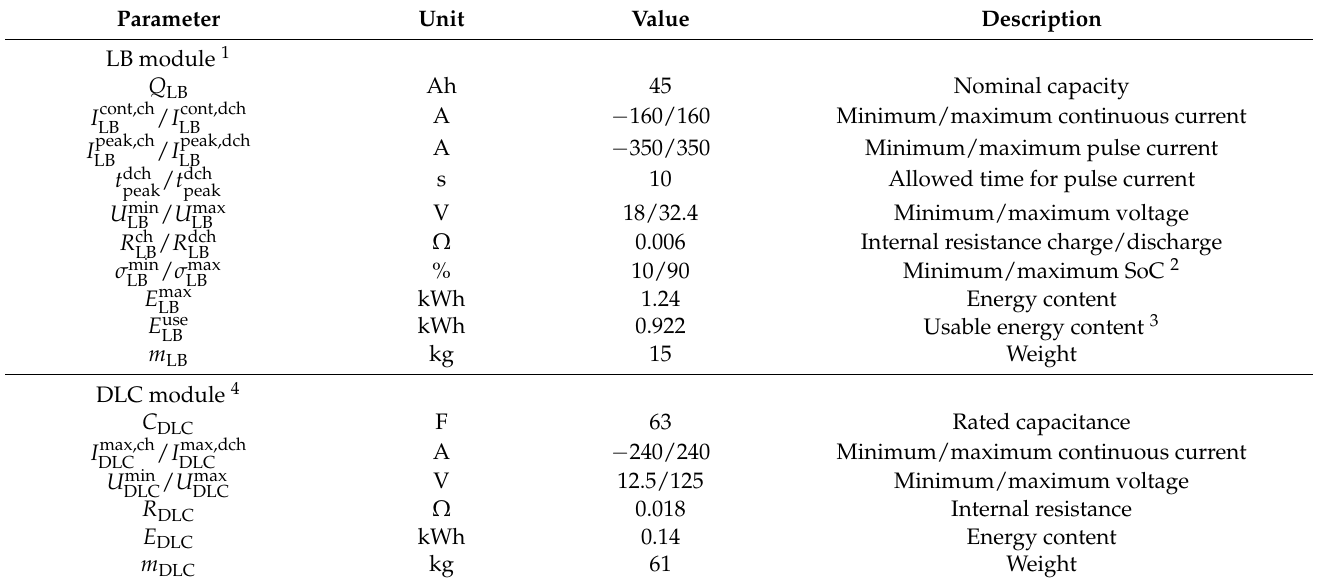
Table 2. Parameters of the selected lithium-ion battery and double-layer capacitor